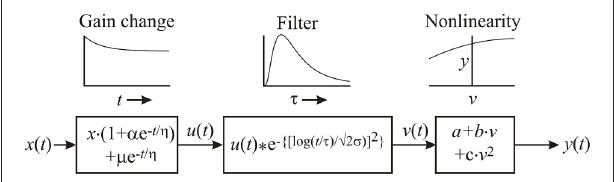
FIGURE 1 | Parametric model of transduction in insect photoreceptors. Light fluctuation as a function of time, x ( t ), passes through an initial stage that reduces its amplitude, and changes its mean level by an exponentially decaying function of time after initial stimulation. Three parameters define this stage: α , the total proportional change in amplitude; µ , the total change in mean level; and η , the time constant for both. The resulting signal, u ( t ), is convolved with the log-normal photoreceptor filter function of Payne and Howard (1981), with its two parameters, τ and σ . Finally, the output of the log-normal filter, v ( t ) passes through a static (time independent) nonlinearity formed by a second-order polynomial function with parameters a , b , and c